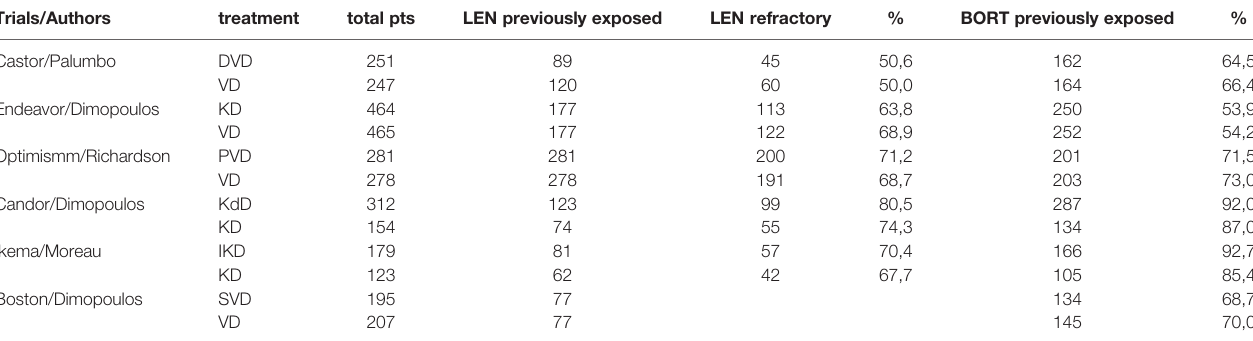
TABLE 1 | Main characteristics and previous treatments of the clinical trials included in the network